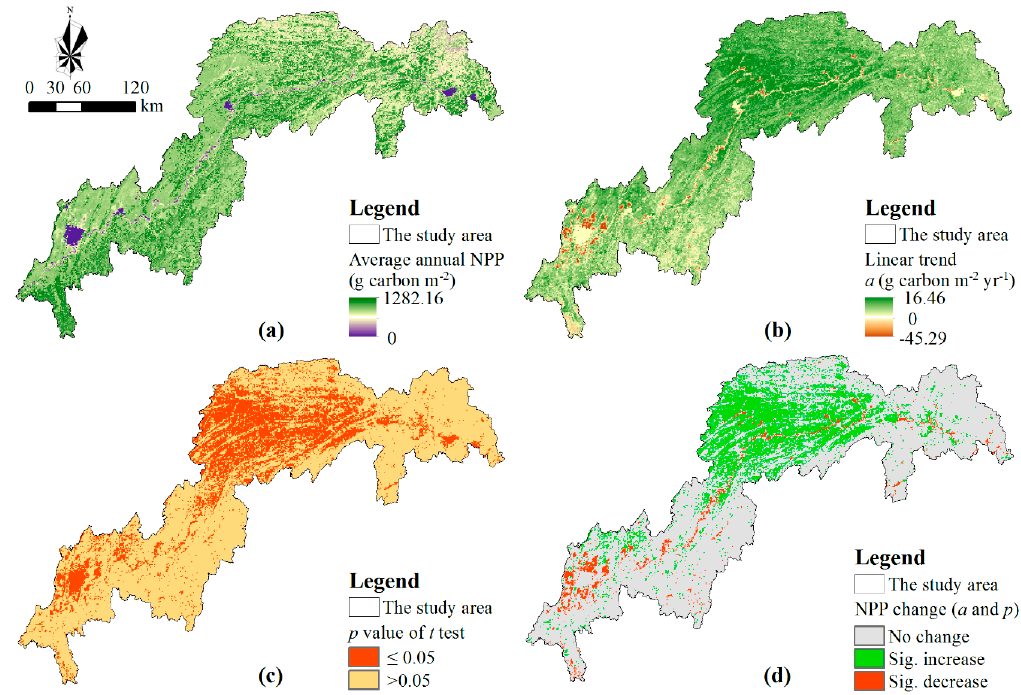
Figure 3. Spatiotemporal variations of annual NPP in the TGR area at the pixel level. Average annual NPP ( a ) change trends of annual NPP; ( b ), the p -value of t-test for the modeled slopes ; ( c ), and the NPP change types ( d ). Note : The least-square linear regression model was applied to analyze the temporal variation of annual NPP from 2000 to 2015 for each pixel, and the changing trend is described by the modeled slope which is recorded by a in the figure ( b ). In the figure ( d ), No change documents that